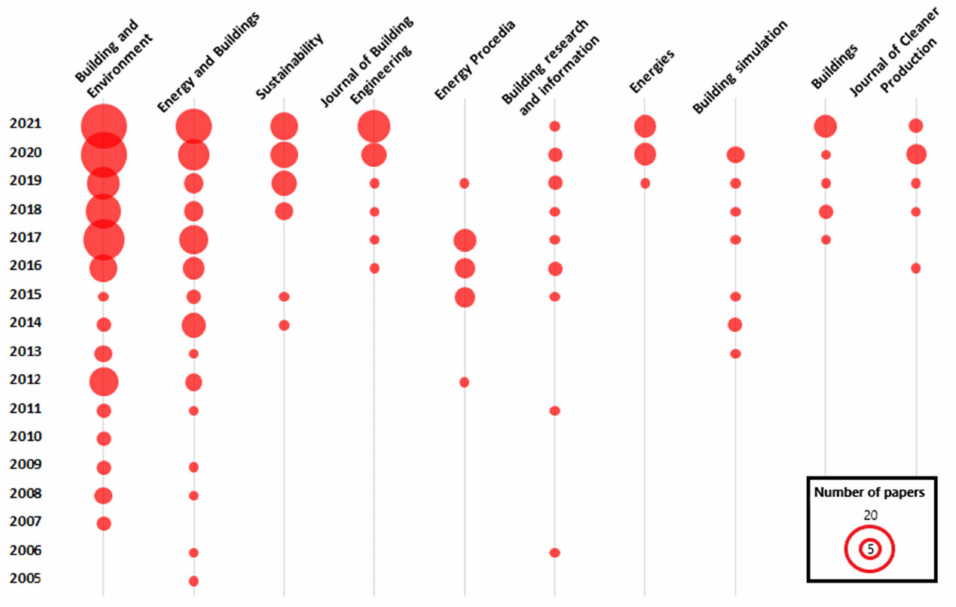
Figure 7. Consecutive progress of published papers in primary sources. Table 1. Journals published the most in the IEQMI